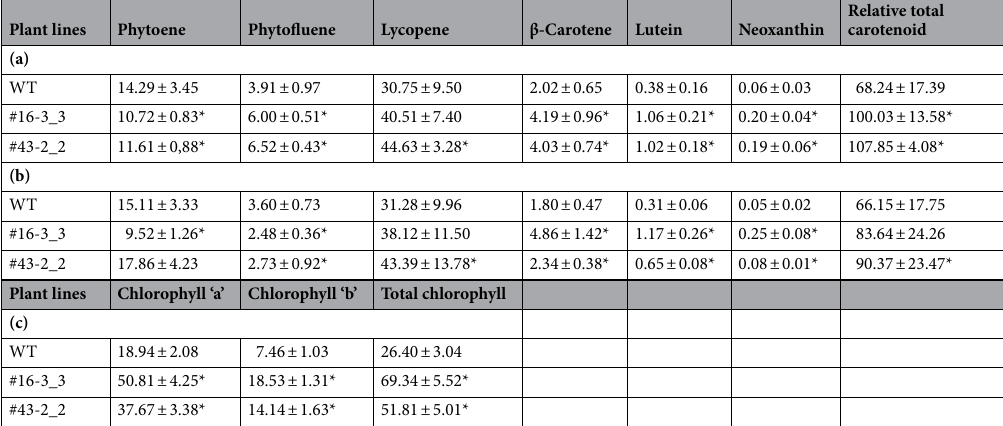
for SlDET1 in all lines, with an average of 15% to 25% (Supplementary Table S1). This was observed upon direct PCR product sequencing in the T 0 generation, with very low histogram peaks mix noticed downstream of the indel site on Sanger reads (Supplementary Fig. S2), coming from the presence of few amplificons of the DNA strand carrying indel, resulting in a potential error of interpretation as a noise background. This low amount of indel can also be noticed by the few amounts of heterozygote plants carrying an indel in the next generation (Supplementary Table S3). The mutations in SlDDB1 and SlDET1 originally described in previous publications regarding hp tomato mutants 17–19 , resulted in SNPs that do not induce total knockout of the gene, probably due to lethal effects in the homozygous condition. As indels were present only in the heterozygous condition for SlDDB1 and SlDET1 (Supplementary Table S3), this could have resulted from a potential deleterious effect of the knockout of these genes . In the case of SlDET1 , the original Slhp2 mutation led to alternative splicing, inducing a deletion of three amino acids in exon 11, resulting in a truncated NLS 19 . However, this mutation was described as an incomplete knock-out mutation, with approximately 10% of the mRNA being correctly spliced. No indel allele mRNA of SlDDB1 has been reported previously. In our case, the absence of homozygous plants for an indel in SlDDB1 or SlDET1 could be explained by the necessity for a small amount of functional protein, as no T 2 homozygous indel lines could be obtained from line #18, which showed the highest segregation of indels. Two alleles of SlDDB1 could be obtained, with greater availability of the single SNP version. For SlDDB1 , one mutation was located 4 bp from the original Slhp1 mutation, resulting in the substitution of the subsequent amino acid compared to the original mutation 17 . The substitution of alanine by threonine was located at a posi- tion that is not strongly conserved compared to the previous asparagine to tyrosine substitution in Slhp1 (Sup- plementary Fig. S3) . As each amino acid belong to a different group, exhibiting a hydrophobic side chain or an uncharged polar chain, respectively, these substitutions might induce a change of conformation of the protein. However, the substitution of aspartic acid by histidine at amino acid 315 in line #42-2-2 occurred in a strongly conserved domain, potentially resulting in a strong effect on plant growth, explaining the difficulty of obtaining a homozygote for this position (Supplementary Fig. S3). A potentially stronger effect on carotenoid accumulation compared to line #16-3-3, with a codominant effect, may be considered. The impact of this mutation should be observed in segregating homozygotes in the T 2 population. Impact on photomorphogenesis could be observed with smaller hypocotyl of double mutant grown under light and dar conditions (Supplementary Fig. S1b,c) as reported previously in tomato 18 . But analysis of impact of each mutation on segregation generation should be performed to confirm if we have an additional effect of both mutations on the plant growth, as reported 18 . The generation of a truncated protein is possible by the introduction of a stop codon, as in our example involving SlCYC-B . The original Slog c mutant has been reported to exhibit an insertion resulting in a frameshift, showing the nonlethal effect of knocking out the gene. As the SlCYC-B target resulted in a stop codon and, thus, a predicted truncated protein, the mutant should show a darker orange flower phenotype compared to the WT, as described in Slog mutants 20 . Interestingly, we could not clearly observe such a phenotype of tawny orange flowers (Fig. 3). The Sl CYC-B protein also functions as a neoxanthin synthetase in addition to a chromoplastic lycopene-β-cyclase, which results in the transformation of violaxanthin to neoxanthin 31 . In our loss of function of SlCYC-B lines, we do not observe a decrease in β-carotene or neoxanthin contents as expected. Interestingly,